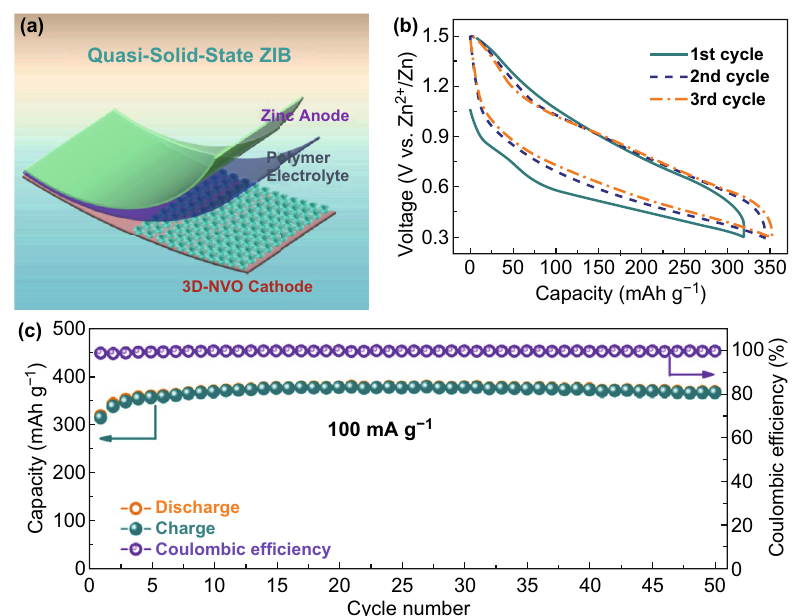
Fig. 5 a Schematic illustration of the configuration of the quasi‑solid‑state ZIB composed of the 3D‑NVO cathode. b The charge/discharge pro‑ files for initial three cycles and c cycling performance at 100 mA g